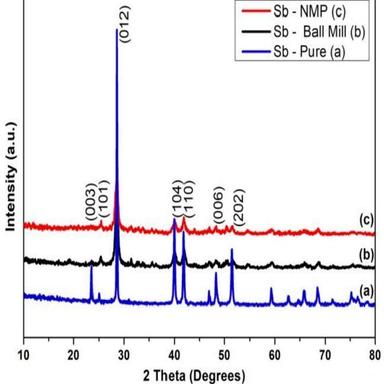
XRD (a) pure Sb and (b–c) ball-milled Sb, NMP treated Sb. Fig. 3. Raman spectra (a) bulk antimony, (b) ball-milled antimony (c) antimonene (8 h).